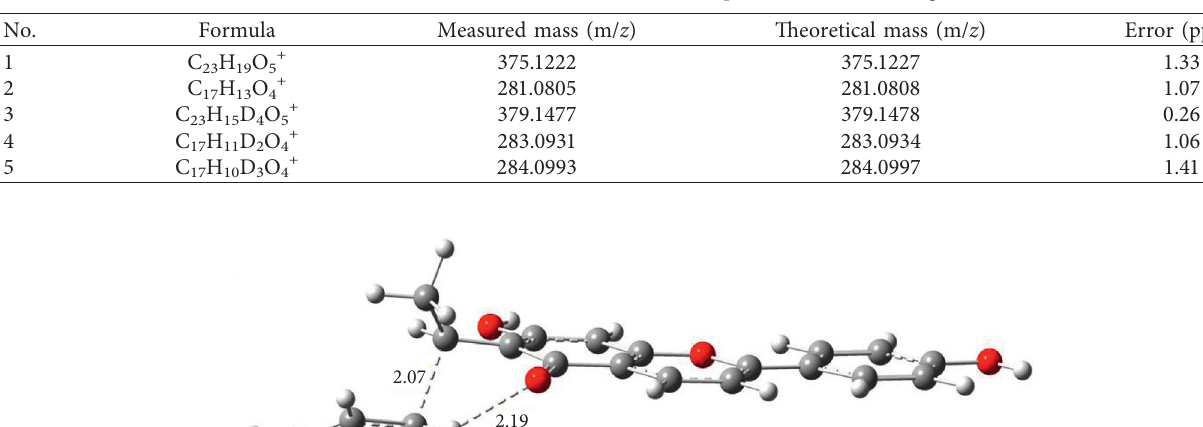
Table 1: The accurate mass data and elemental compositions of ions in Figure S2.